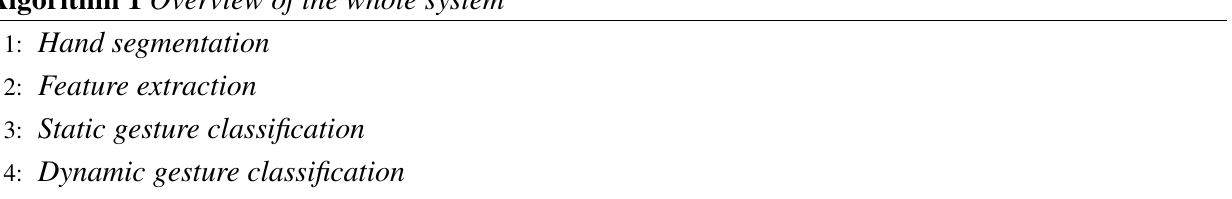
Algorithm 1 Overview of the whole